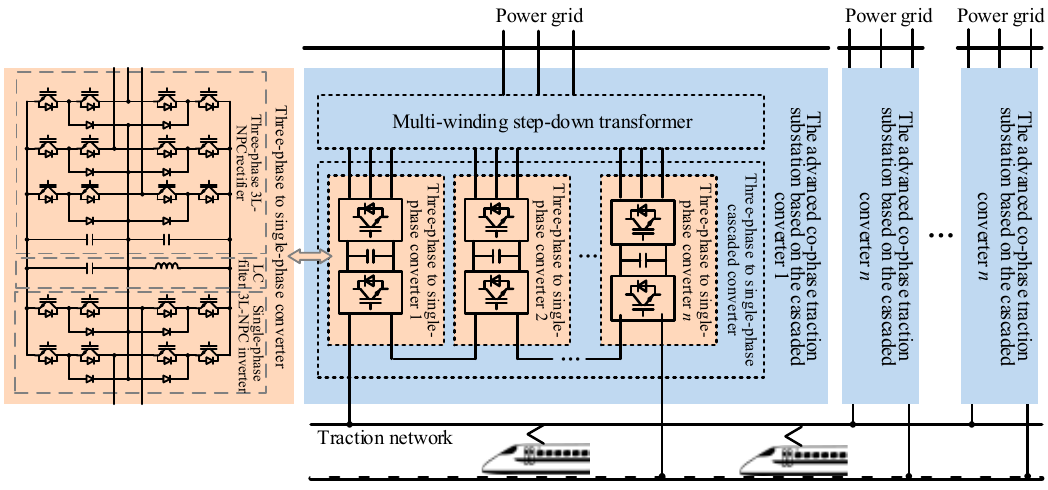
Figure 2. The structure of the advanced co-phase traction power supply system (ACTPSS).